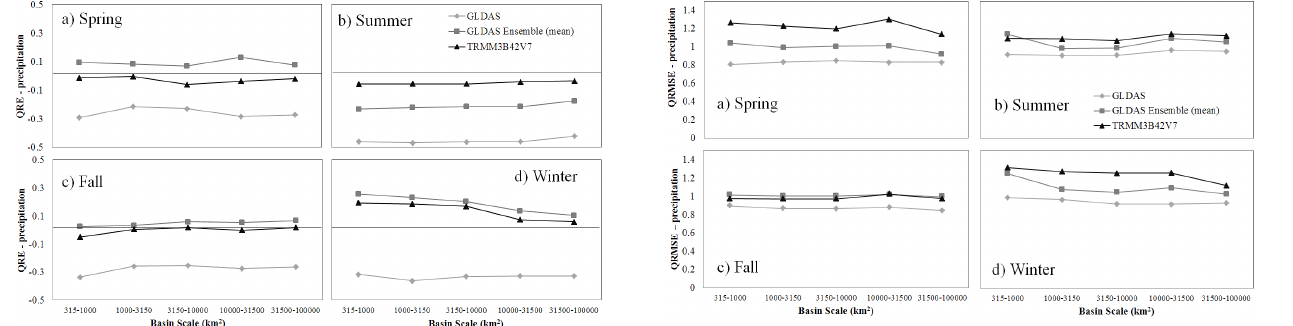
Figure 8. QRE error metric determined conditional to reference precipitation values exceeding their 90th percentile. The horizontal axis indicates basin-scale categories presented in Table 2. Results are presented for spring (upper left panel), summer (upper right), fall (lower left), and winter (lower right) seasons.